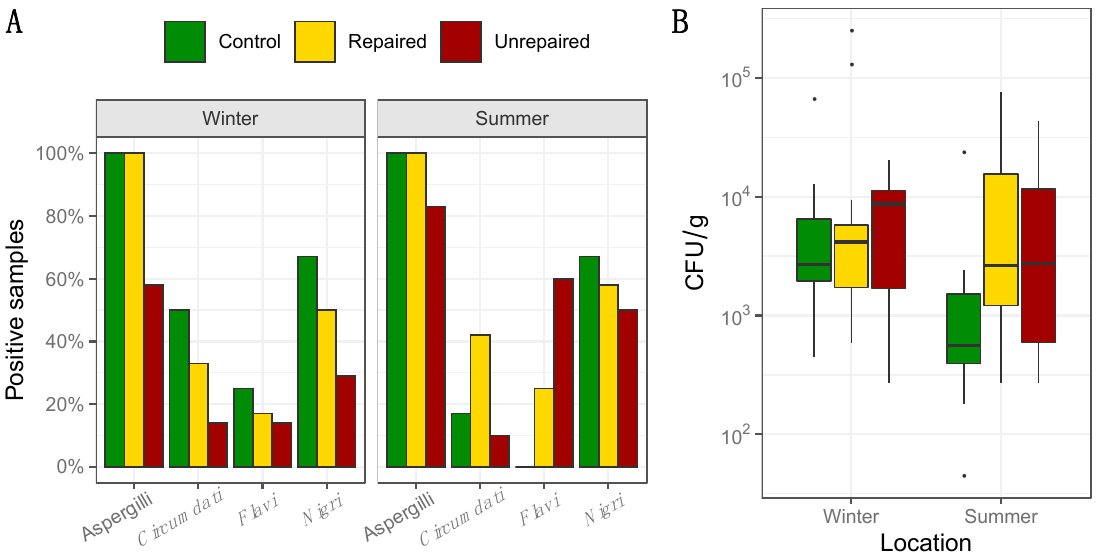
Figure 2. Percentage of positive samples where total dust borne Aspergilli, as well as Aspergilli from the sections Circumdati , Flavi, and Nigri, were detected based on analysis of 12 samples of dust collected at control and repaired locations, and 10 samples of dust collected at unrepaired locations in each sampling period, i.e., winter and summer ( panel A ); Concentration of total Aspergilli (CFU/g) detected in dust. Each location is represented by a box–whisker plot in a different shade of gray in each sampling period (winter and summer) as specified ( panel B ).